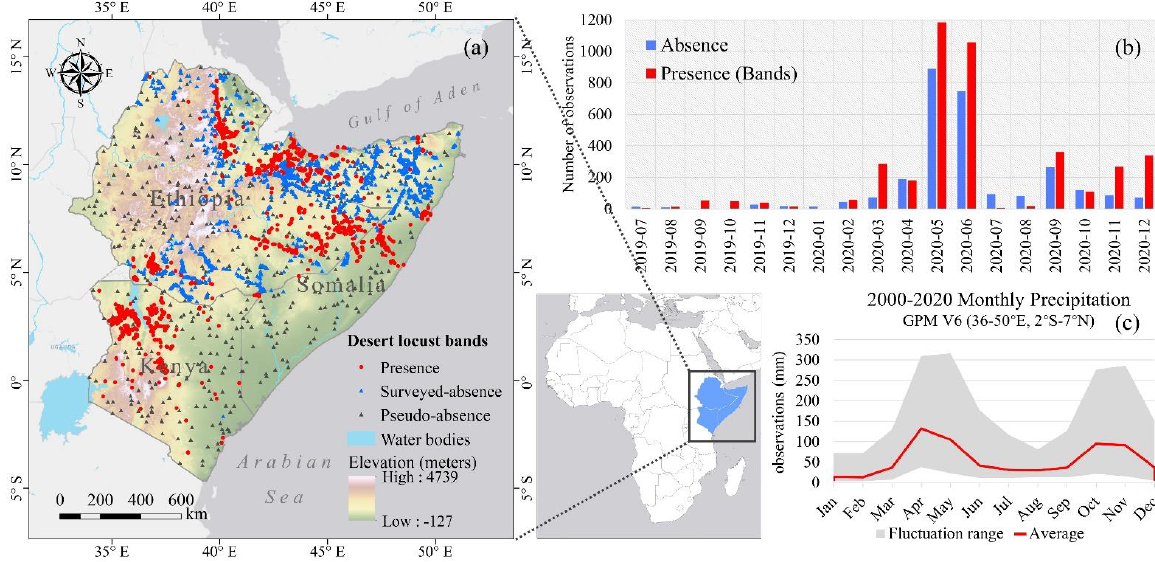
Figure 1. Spatial and temporal distribution of ground points of the desert locust band used for this study in the SEK region. ( a ) The geographical location of SEK with band observations in 2000 – 2020; the red dot represents band presence while the blue triangle refer to surveyed-absence and the grey one indicates pseudo-absence. ( b ) Monthly count of bands from July 2019 to December 2020. ( c ) Monthly observations of Global Precipitation Measurement (GPM) V6 in the central SEK region for 20 years (2000 – 2020); the red line indicates monthly mean rainfall; the grey area indicates the fluctuation interval.